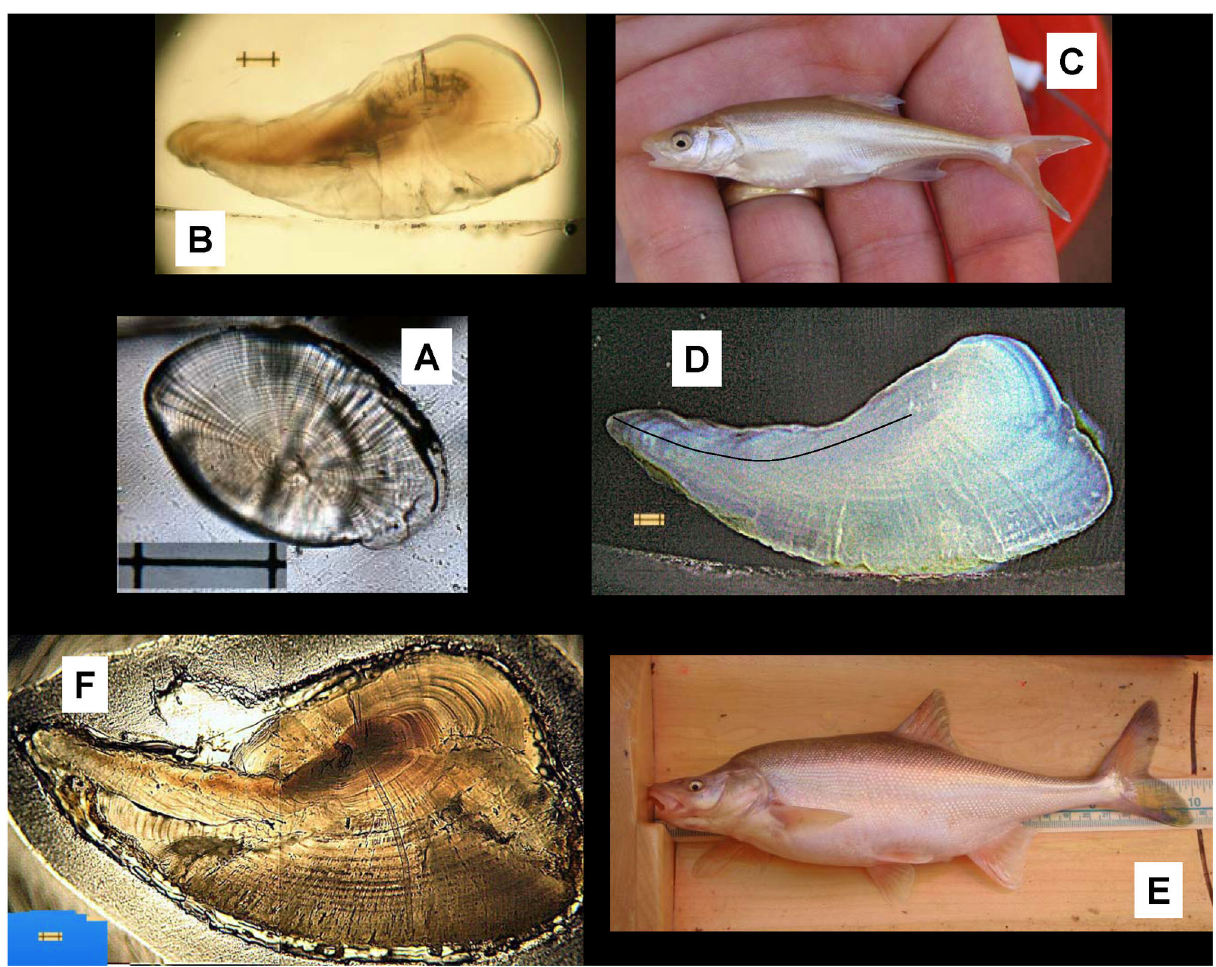
Figure 1. Collage of humpback chub and their lapillar otoliths. Older, larger fish have larger, more curved otoliths. Clockwise from left center: A – otolith of a 20 mm post-larva with 32 daily growth increments; B – otolith from a 2 year old, 114-mm subadult; C – subadult humpback chub (Photo: C. Finch); D – otolith from a 7 year old, 230-mm adult, with line drawn along the axis of measurement; E – old humpback chub (Photo: C. Finch); F – otolith with laser ablation track from a 28 year old, 383-mm chub. Bar on otolith images = 100